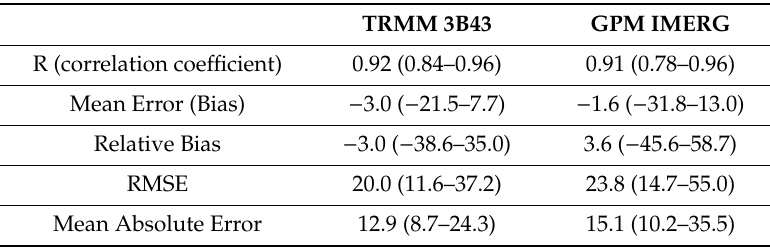
Table 2. Performance evaluation metrics of monthly data from 3B43V7 and IMERG (the range of values is given in